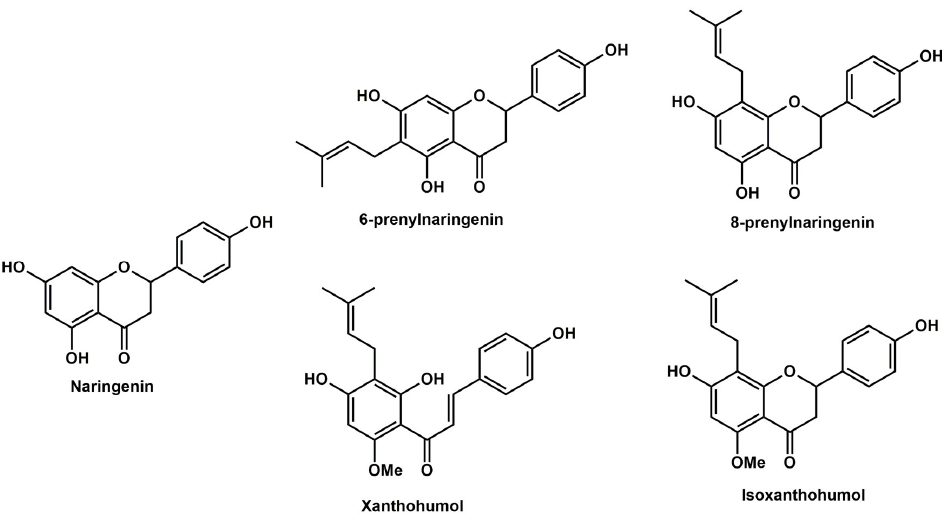
Figure 1. Chemical structures of the studied prenylflavonoids and